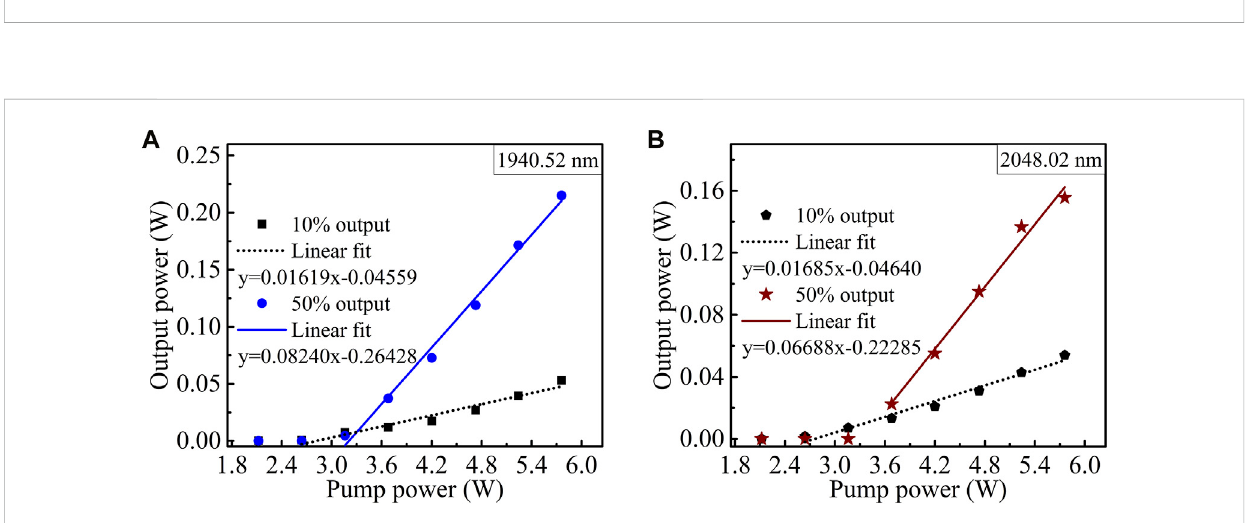
FIGURE 5 Output power versus pump power when the central wavelength is (A) 1940.52 and (B) 2048.02